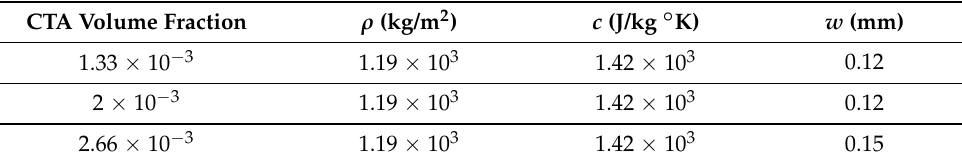
Figure 15. Temperature change as a function of intensity calculated from Equation (4) using the time constants measured from the photomechanical response, the density, heat capacity, and the sample’s dimensions. The insets show the temperature change per unit of absorbed intensity as a function of CTA volume fraction averaged over all intensities. The plots use t 1 to get ∆ T for vertically and horizontally polarized pumps. Table 5. Values of density ρ , the specific heat c , and thickness w of the fibers used to calculate the temperature